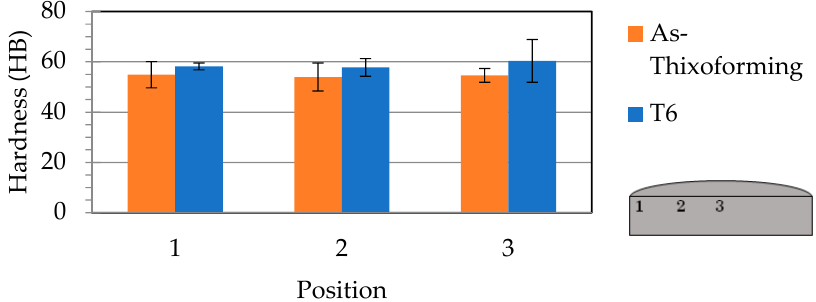
Figure 18. Average hardness of thixoformed A356 / SiC(15%SiC-15 µ m).